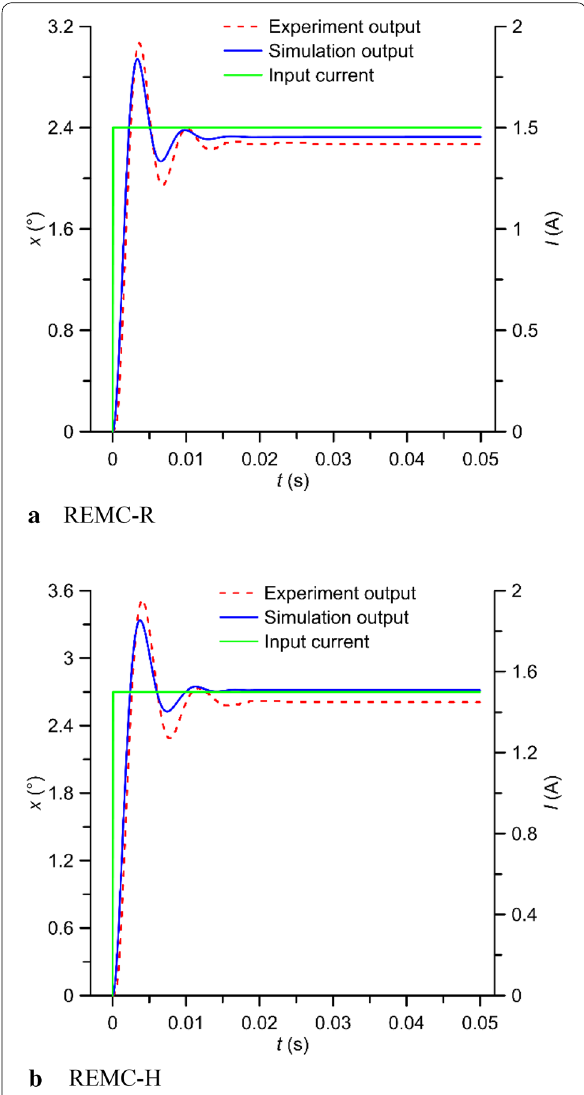
Figure 18 Step response of REMC-R and REMC-H